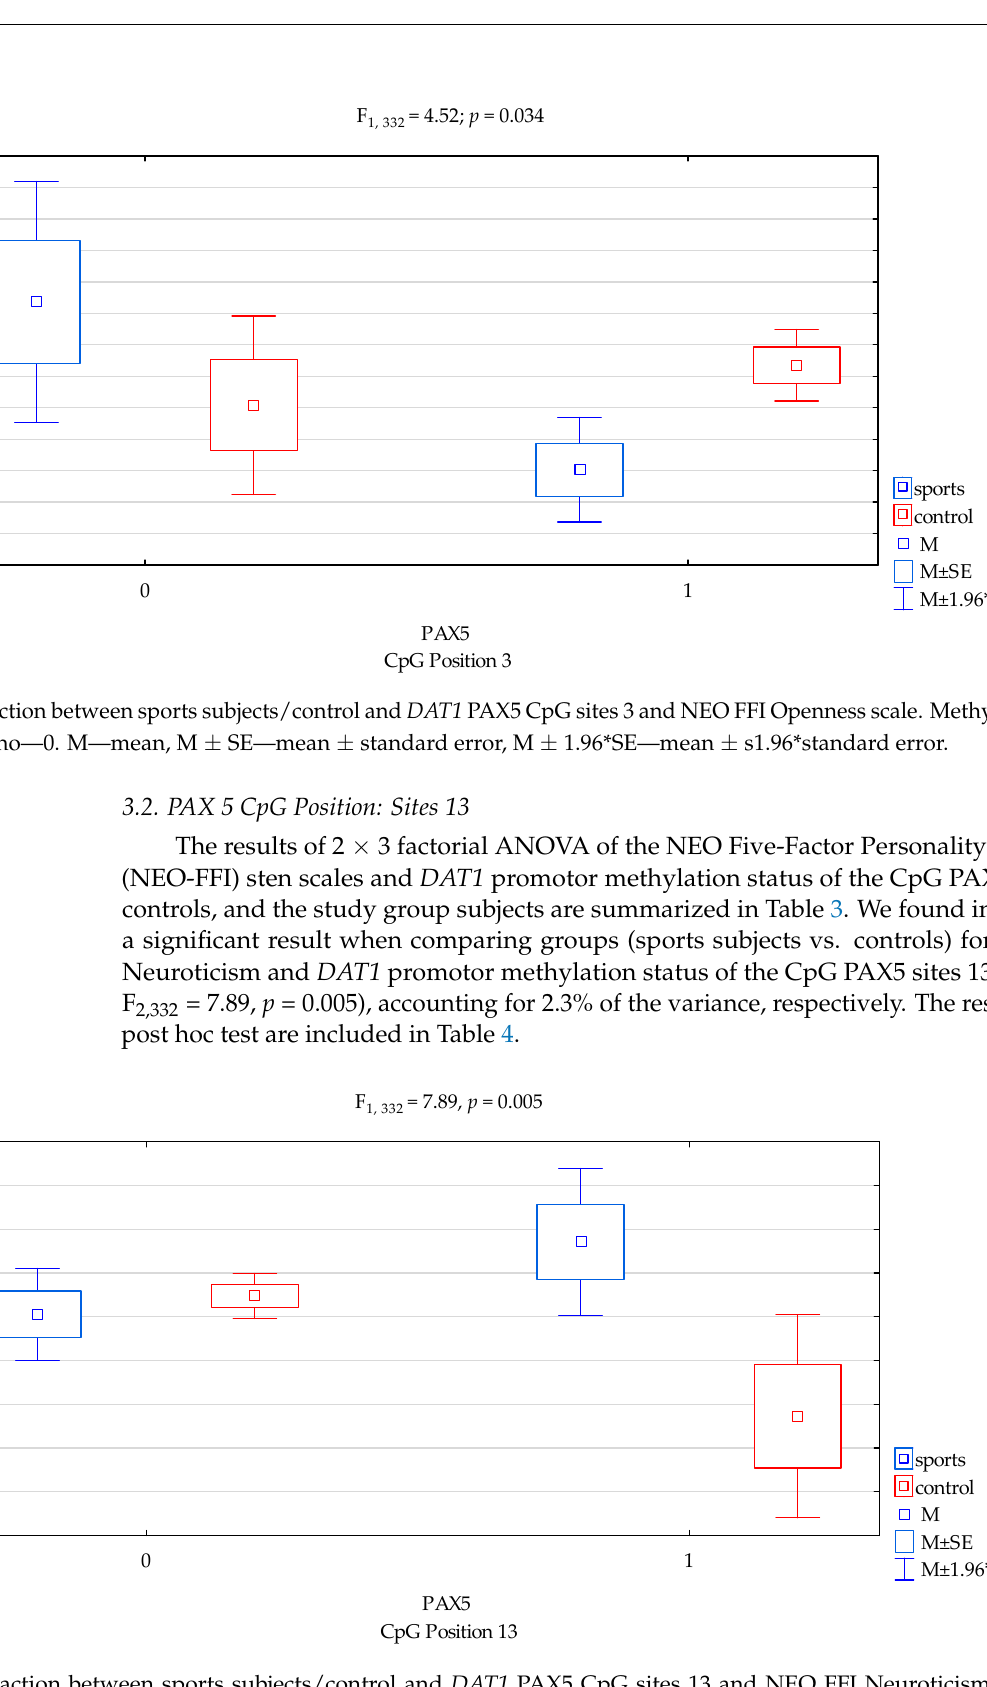
Figure 2. Interaction between sports subjects/control and DAT1 PAX5 CpG sites 13 and NEO FFI Neuroticism scale.